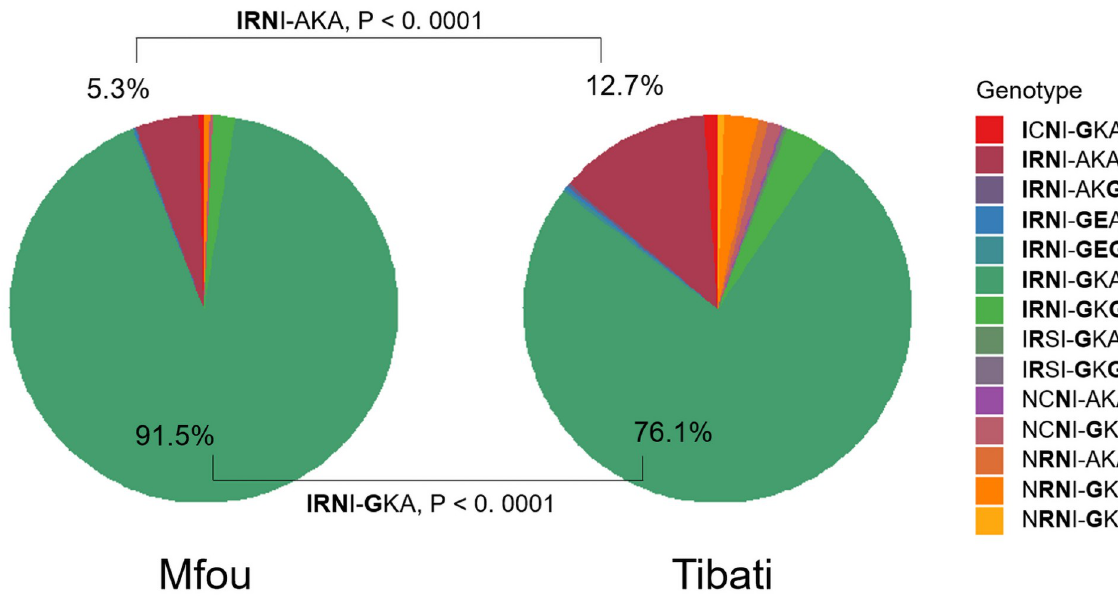
Fig 3. Prevalence of combined Pfdhfr-Pfdhps genotypes in Mfou and Tibati. The quadruple mutant IRN I- G KA was the most prevalent in both study sites, 706/772 (91.45%) in Mfou and 552/724 (76.24%) in Tibati, and the difference is significant ( χ 2 = 64.59, P < 0.0001; Fig 3). The triple mutant IRN I-AKA was more frequent in Tibati (12.7% versus 5.3% in Mfou, χ 2 = 24.98, P < 0.0001; Fig 3). The wild-type genotype NCSI-AKA was never identified. The super-resistant genotype IRN I- GEG , a sextuple mutant associated to high level of SP resistance appeared in two samples from